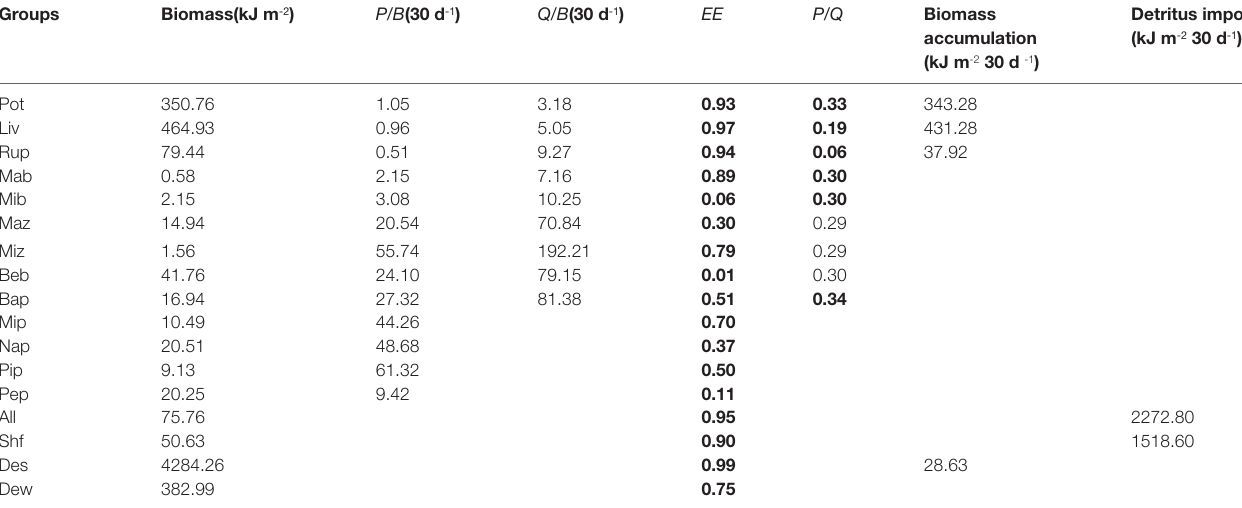
TABLE 4 | Ecopath inputs and outputs for a Portunus trituberculatus polyculture ecosystem model during the middle period. Groups